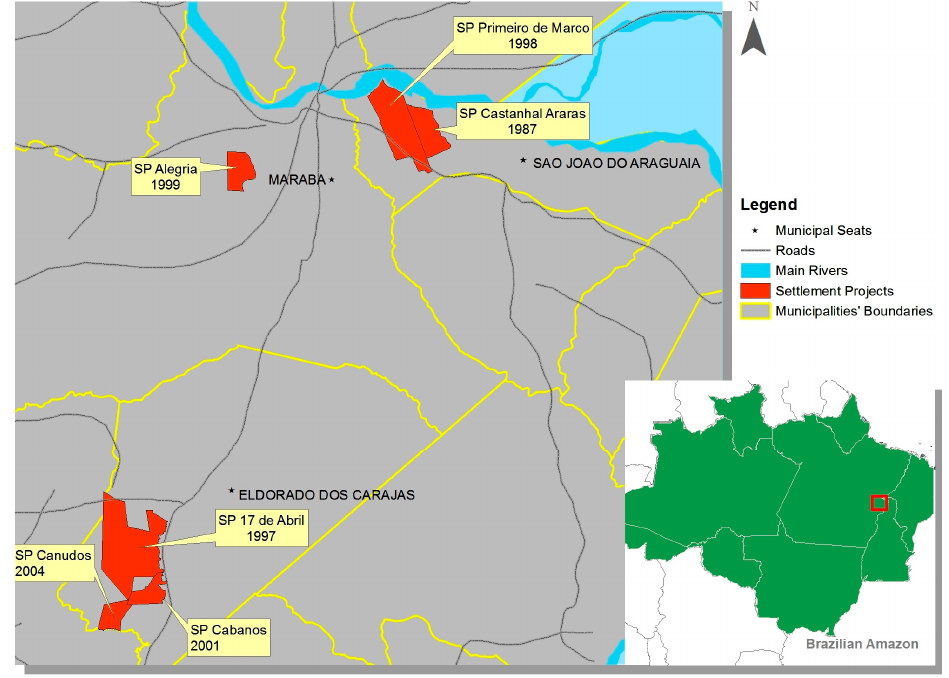
Figure 1. Study area: location and year of creation of settlements in Pará, Brazil. Source: INCRA, 2010 (personal contact).